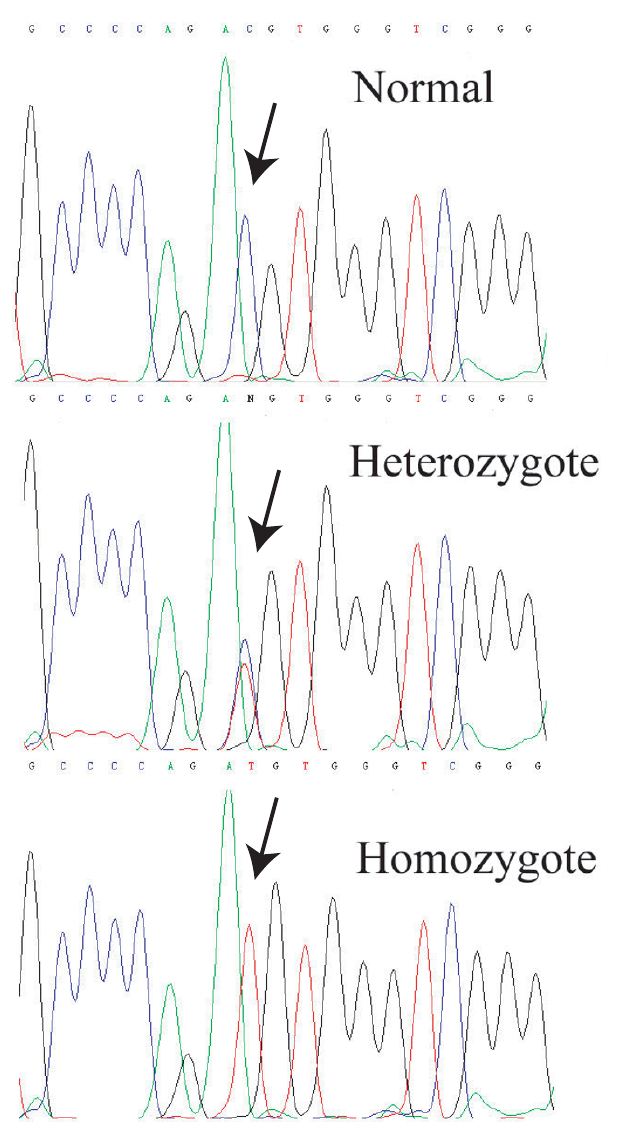
Figure 3 Identification of KCNQ1 mutation T322M (T to C substitu- tion at nucleotide 965). Top, normal sequence; Middle, het- erozygous T322M mutation with both T and C at nucleotide 965; Bottom, homozygous T322M